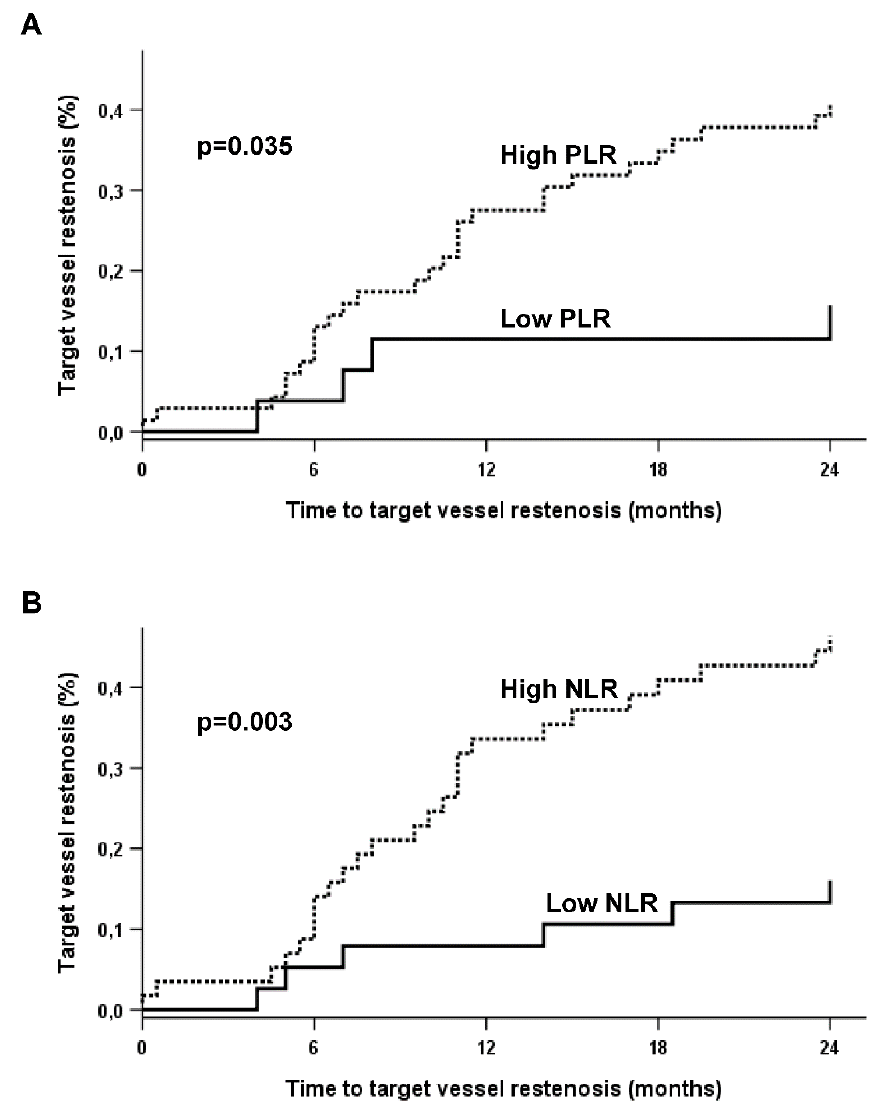
Figure 2. Kaplan-Meier analyses for the cumulative incidence of the primary endpoint in patients with ( A ) high vs. low platelet-to-lymphocyte ratio (PLR), and ( B ) high vs. low neutrophil-to-lymphocyte ratio (NLR). High PLR and high NLR are indicated by the dotted lines, low PLR and low NLR are indicated by the solid lines.